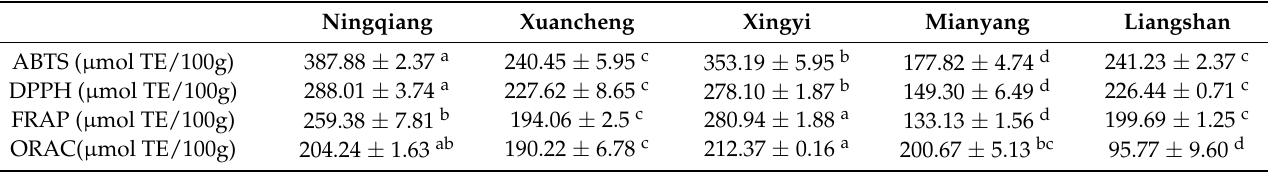
Table 4. Free radical scavenging ability of five regions of